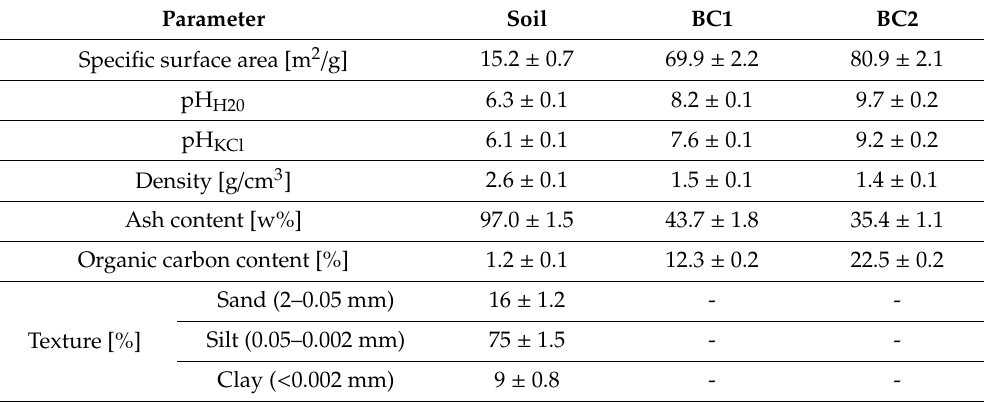
Table 1. Soil and biochar